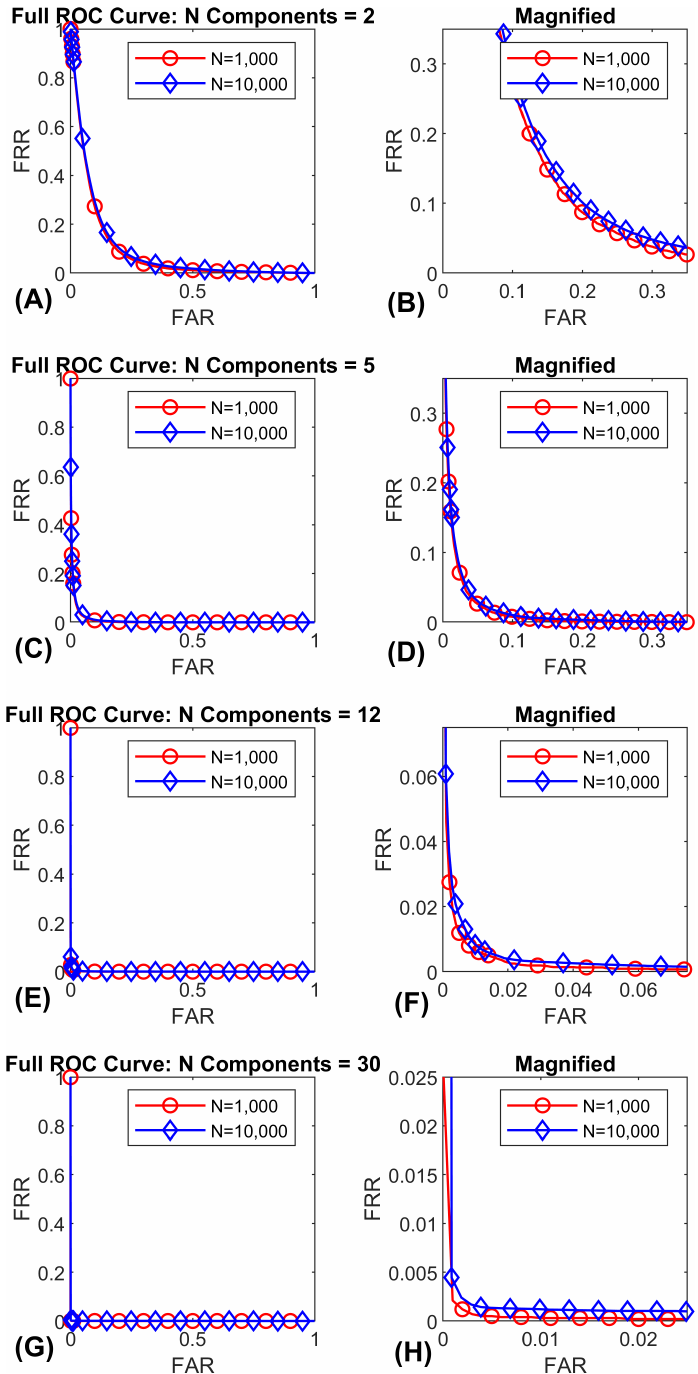
Figure 10. ROC-curves for FaceNet PCA components. Plots for 2, 5, 12 and 30 PCA components are displayed. Each curve was evaluated at 1000 and 10,000 subjects. Each curve is the average over 30 repetitions. ( A ) illustrates the entire 2 ROC-curves for 2 features. ( B ) illustrates the same data in ( A ) zoomed in on the lower error rates for enhanced visibility. ( C ) illustrates the entire 2 ROC-curves for 5 features. ( D ) illustrates the same data in ( C ) zoomed in on the lower error rates for enhanced visibility. ( E ) illustrates the entire 2 ROC-curves for 12 features. ( F ) illustrates the same data in ( E ) zoomed in on the lower error rates for enhanced visibility. ( G ) illustrates the entire 2 ROC-curves for 30 features. ( H ) illustrates the same data in ( G ) zoomed in on the lower error rates for enhanced visibility. Note that the ROC-curves are essentially overlapping across gallery